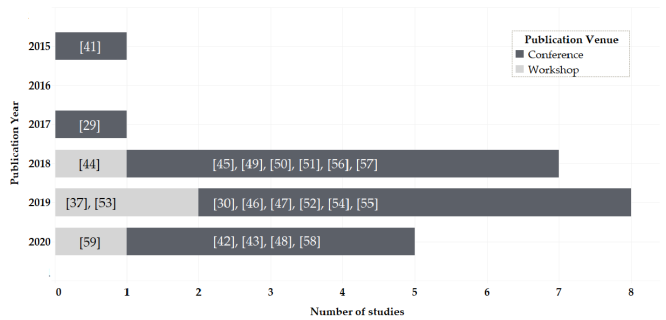
Figure 3. Distribution of studies based on publication year and publication